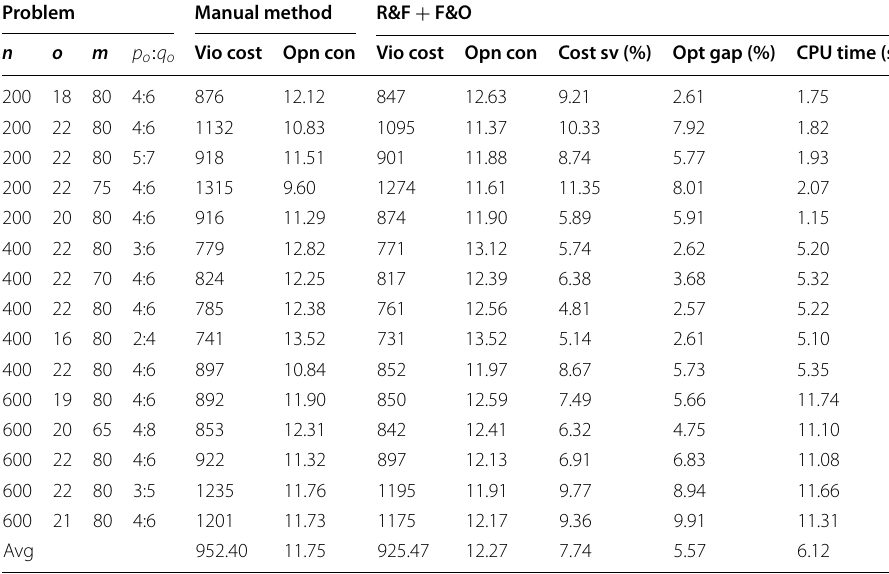
The observed best mean value of upper bound for each instance is marked as bold Table 4 Results of the algorithm with fifteen months of real-world data